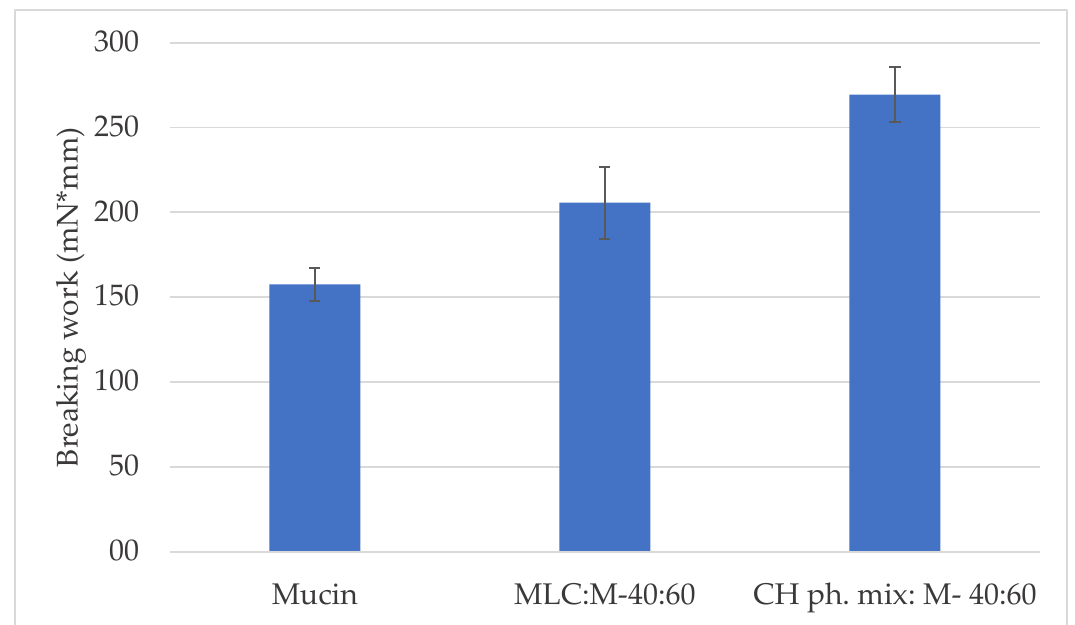
Figure 8. Comparison of breaking work values between tablets containing mucin, CH physical mixture (CH ph.mix) or microparticles (MLC) 40:60 with mucin (M). NAC Release through Artificial Mucus (AM)